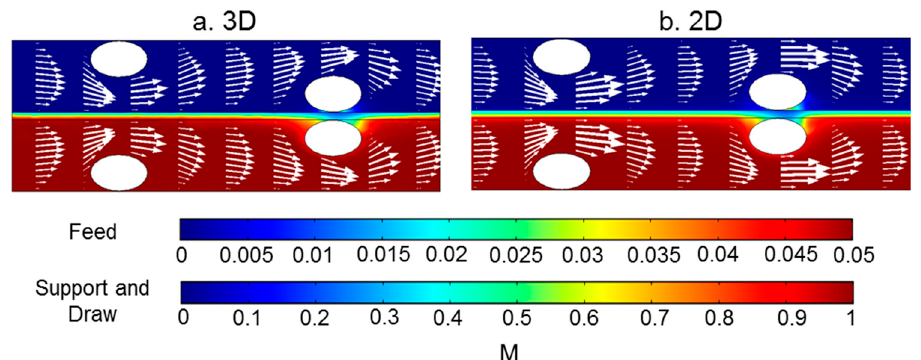
Figure 12. Concentration profile (indicated by the color flood) and velocity profile (indicated by the arrows) in ( a ) the middle section of the 3D model and ( b ) the section from the 2D model where the distance to the entrance was from 9.5 mm to 14.5 mm. The size of the arrows is proportional to the value of the velocity.